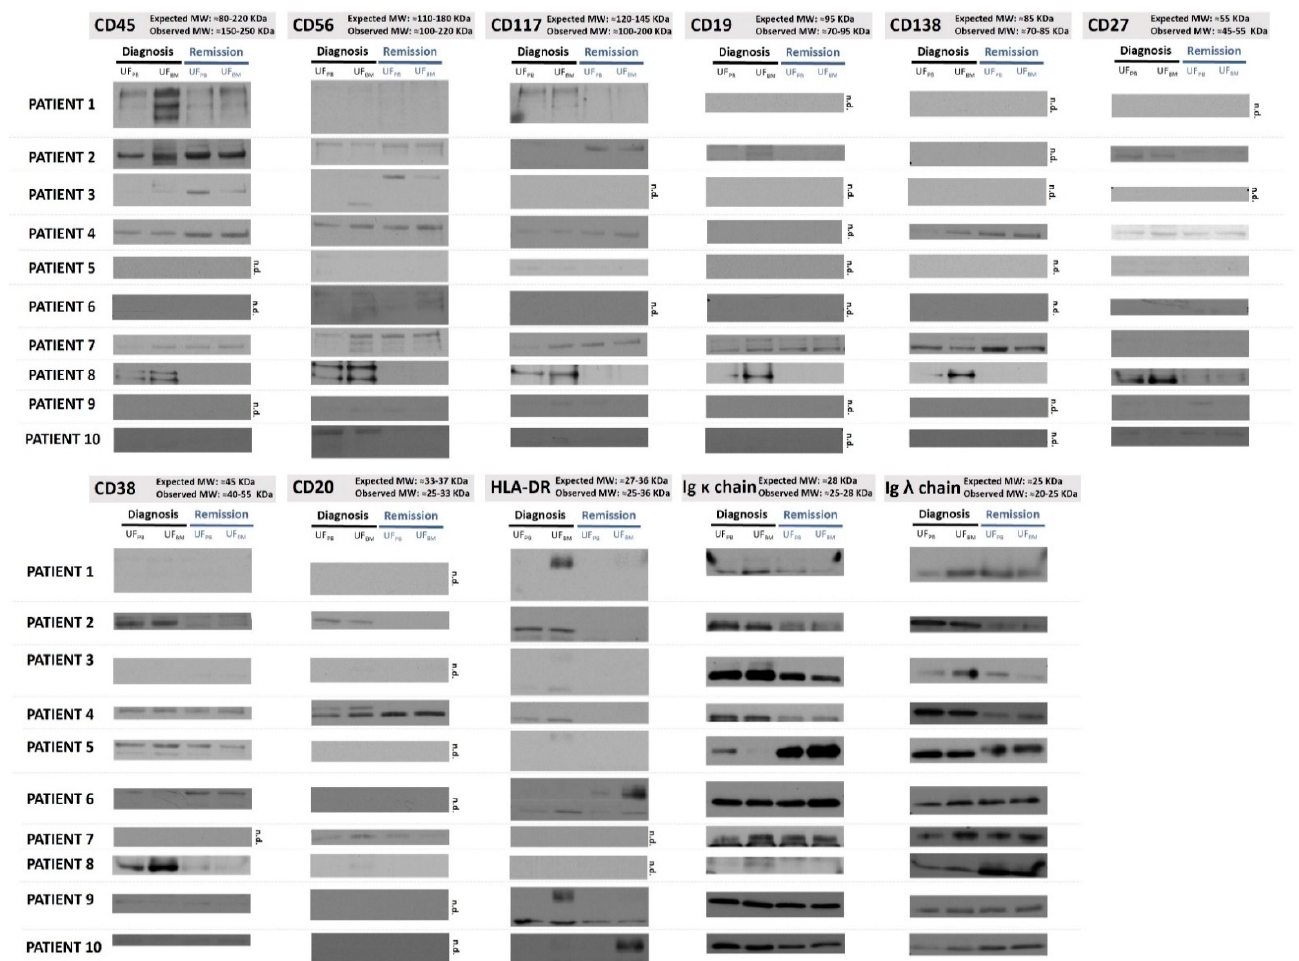
Figure 3. Detection of Multiple Myeloma (MM) and Minimal Residual Disease (MRD) Markers in EVs from diagnosis and remission samples from the peripheral blood (PB) and bone marrow (BM) of MM patients. Different markers of MM and MRD were analyzed by WB in the ultrafiltrated pool from SEC fractions 3 to 6 (UF) isolated from PB and BM samples collected at both diagnosis (first two lanes) and remission (final two lanes) from 10 MM patients (n.d.: signal not detected). The molecular weight (MW) of the bands is shown in kDa on the right side of the blots. MM: Multiple Myeloma; MRD: Minimal Residual Disease; PB: peripheral blood; BM: bone marrow; SEC: Size Exclusion Chromatography; WB: Western Blot; UF: ultrafiltrated pool from SEC fractions 3 to